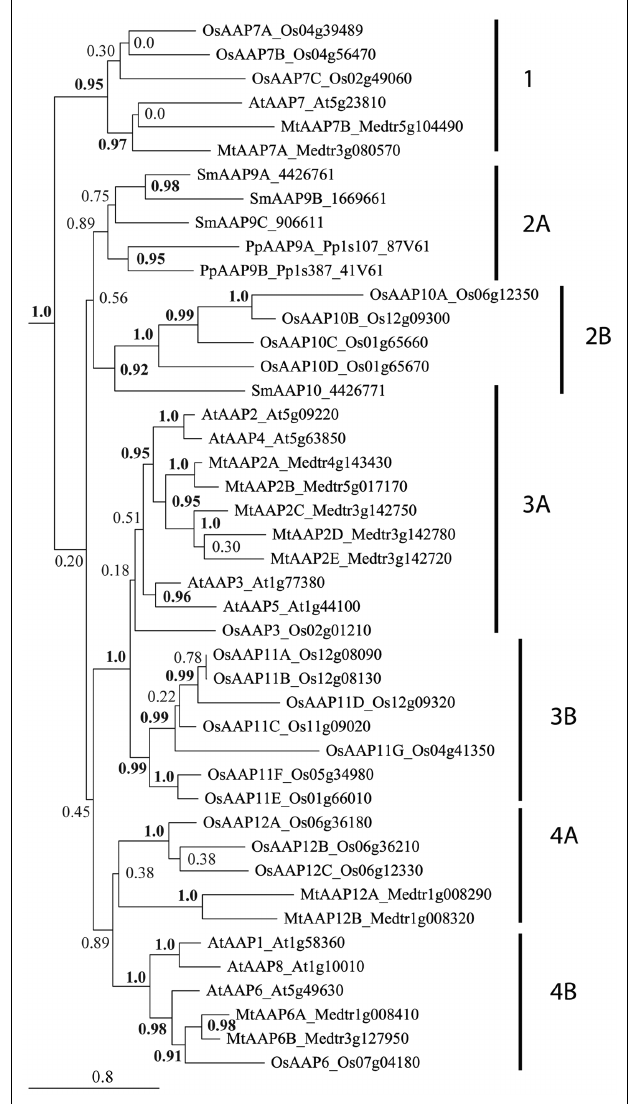
FIGURE 3 | Phylogenetic analysis ofAAP proteins found in Arabidopsis thaliana (At), Oryza sativa (Os), Medicago truncatula (Mt), Selaginella moellendorffii (Sm), and Physcomitrella patens (Pp). Multiple protein sequence alignment was done using CLUSTAL X (Thompson et al., 2007). A maximum-likelihood tree was constructed using PhyML 3.0 (Guindon et al., 2010). Numbers at the nodes indicate SH-like branch support (Shimodaira and Hasegawa, 1999; Buckley et al., 2001).Values above 0.9 (in bold) show significant phylogenetic support. Accession numbers of sequences (see Table 1 ) are provided after the species transporter names.The clusters (numbers) and subclusters (letters) are